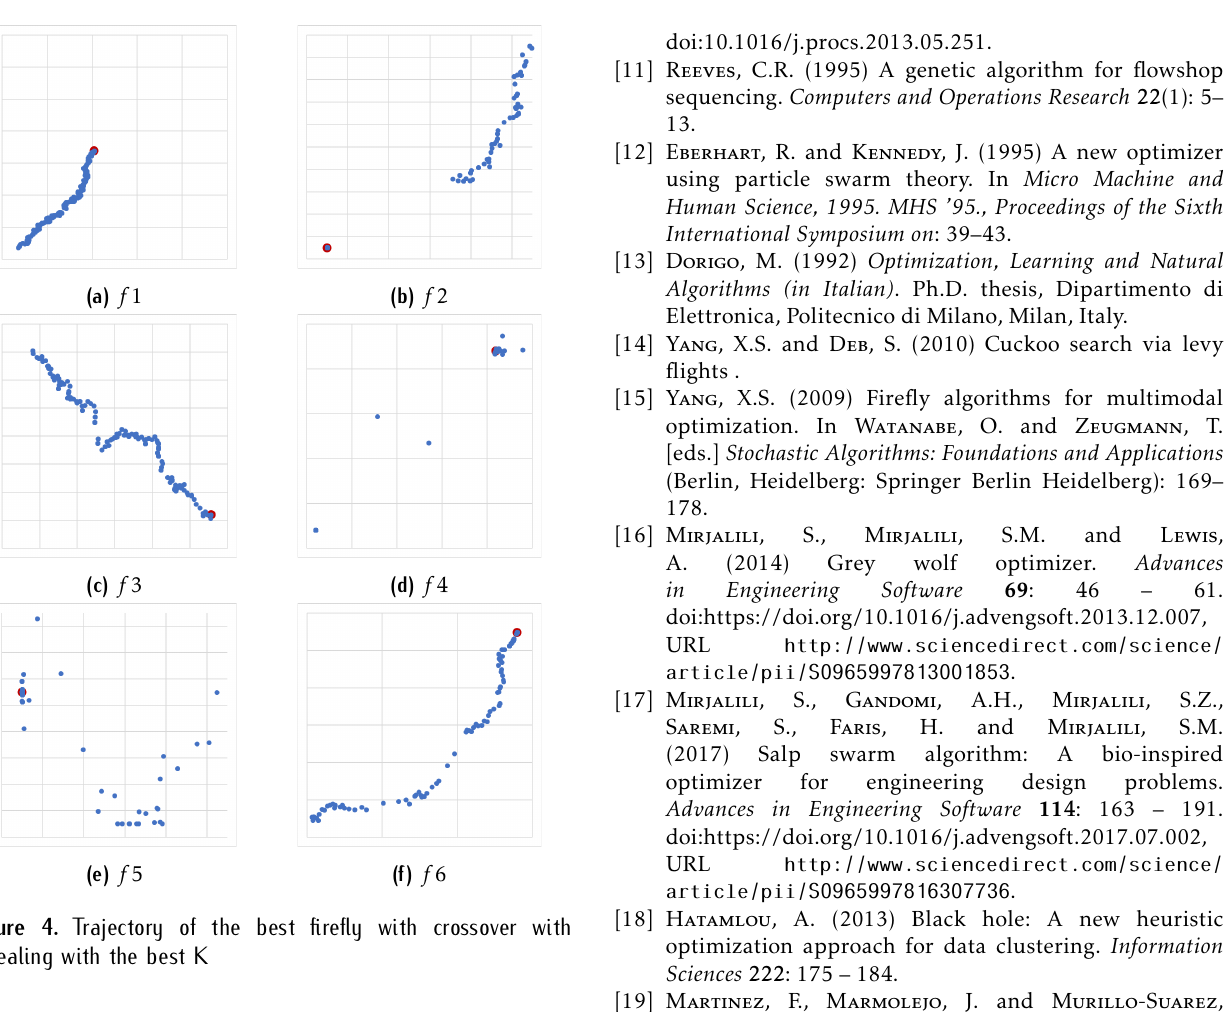
for optimization. Elektrotehniski Vestnik/Electrotechnical Review 80 . algorithm based on atmosphere clouds model.